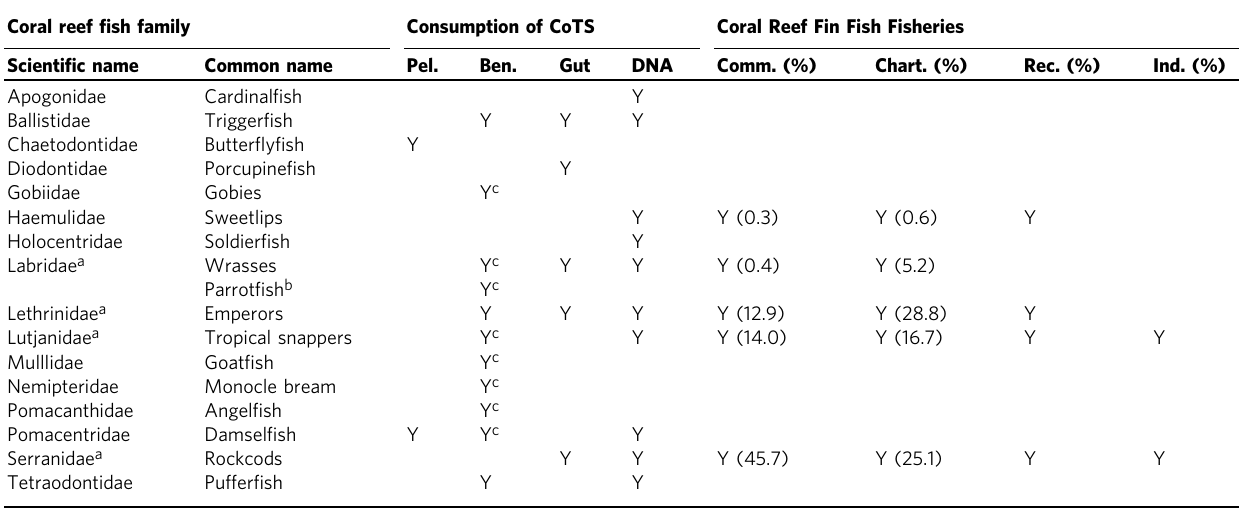
Table 1 Coral reef fi sh known to consume Crown-of-Thorns Star fi sh and targeted by fi sheries in the Great Barrier Reef Marine